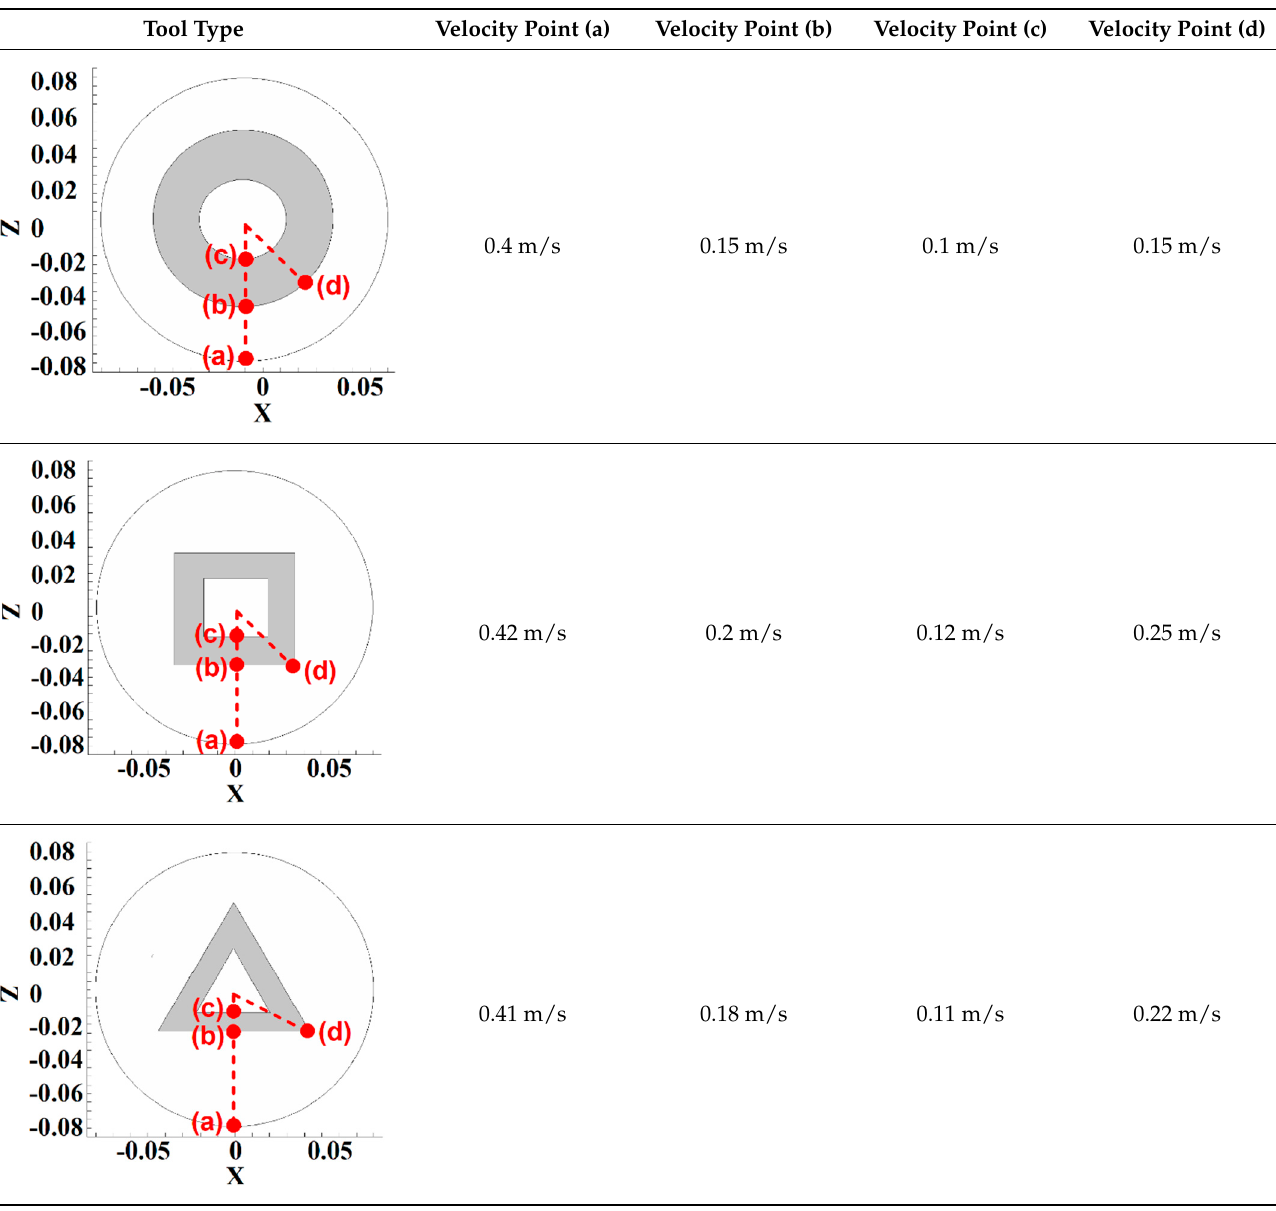
Table 2. Analysis of material velocity.